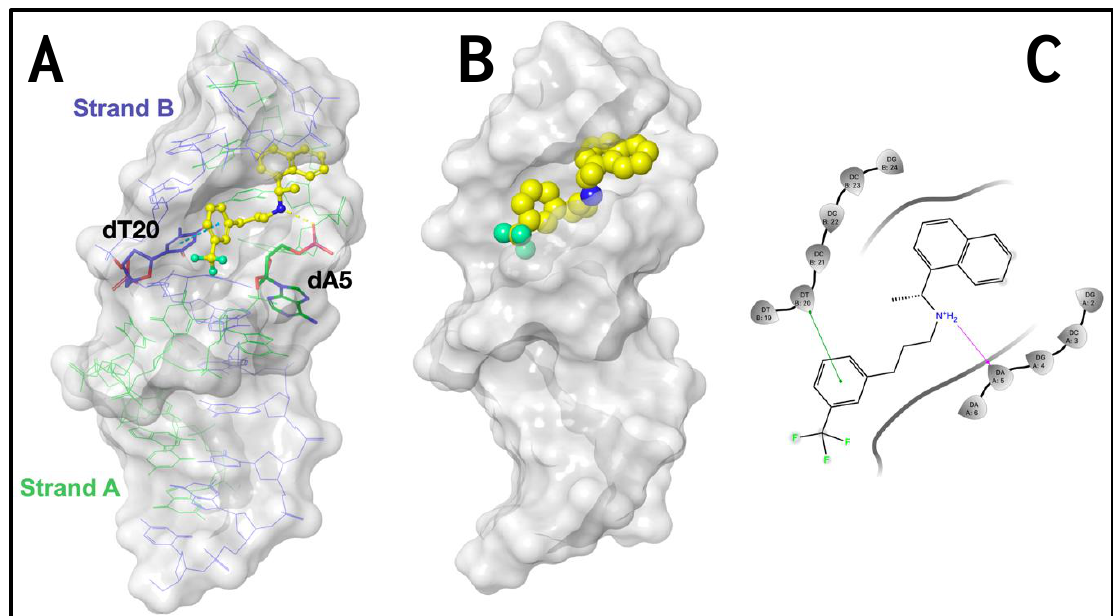
Figure 6. The proposed binding mode of CIN represented as: ( A ) Yellow ball and stick mode; ( B ) CPK mode with dsDNA (represented as gray surface) (PDB: 1BNA) illustrating the interactions observed. Hydrogen bond and π - π contact are represented as: ( A ) Yellow and cyan dotted lines, respectively; ( C ) (in 2D-interaction map) Magenta and green lines, respectively.